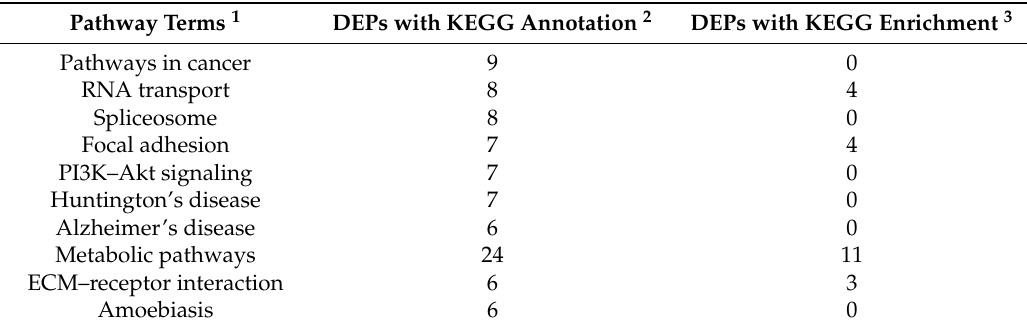
Table 1. Top 10 pathway terms of differentially expressed proteins (DEPs) in KEGG annotation.